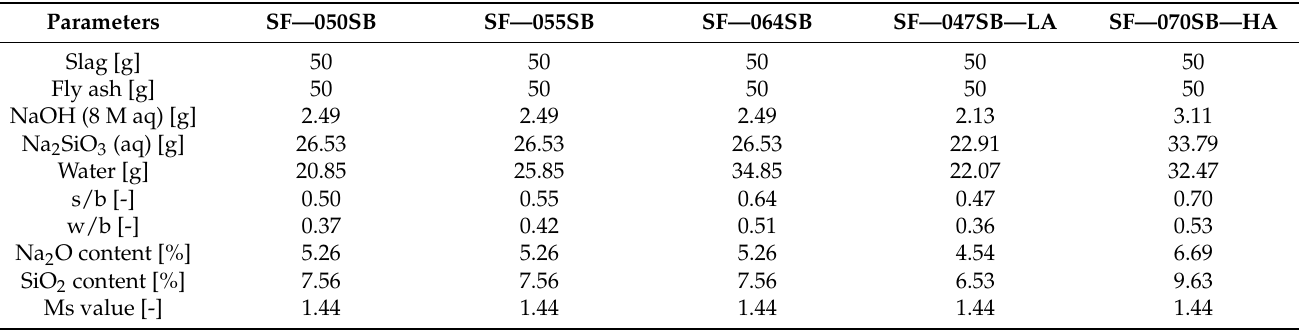
Table 3. Mix design for alkali-activated slag-fly ash binders (100 g of